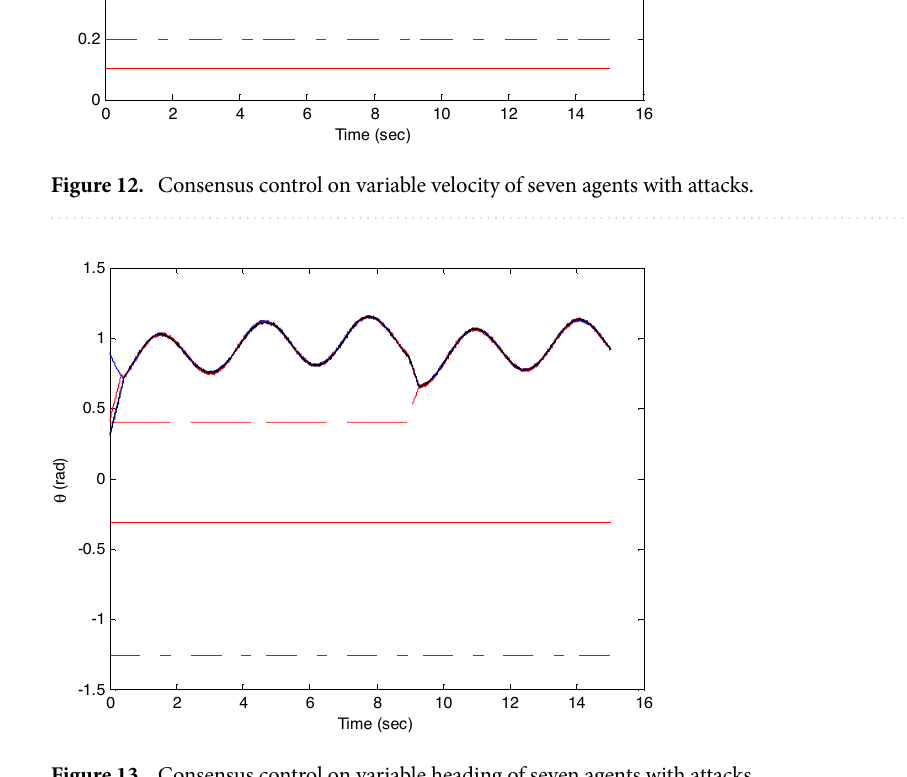
Figure 13. Consensus control on variable heading of seven agents with